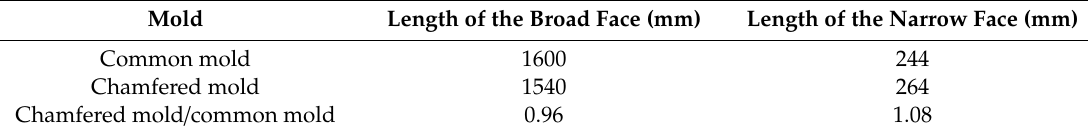
Table 7. The contact lengths of the shells of the chamfered mold and common mold. Mold Length of the Broad Face (mm) Length of the Narrow Face (mm) Common mold 1600 244 Chamfered mold 1540